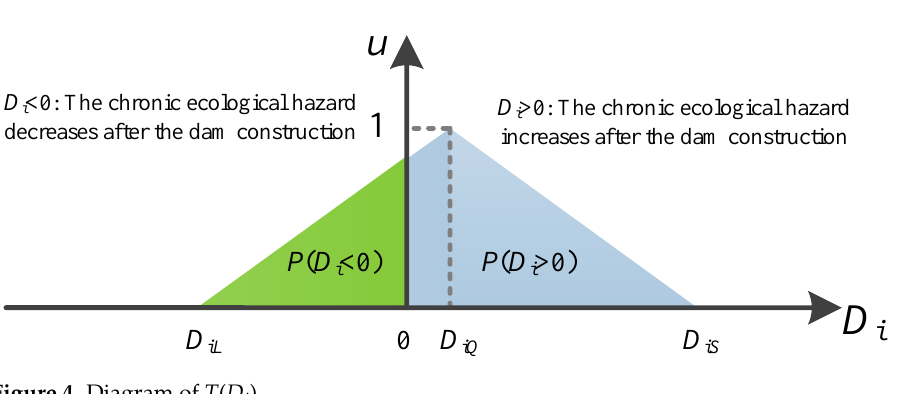
Figure 4. Diagram of T ( D i ).